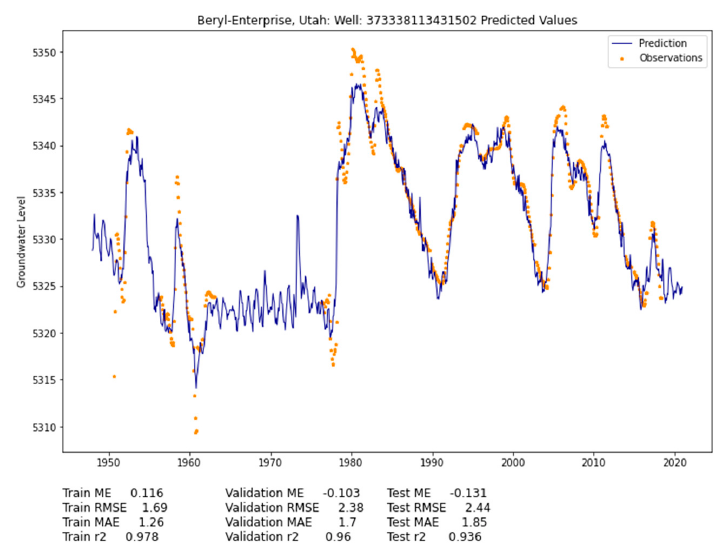
Figure 11. Well 373338113431502 in Beryl-Enterprise, showing groundwater observations and model predictions.